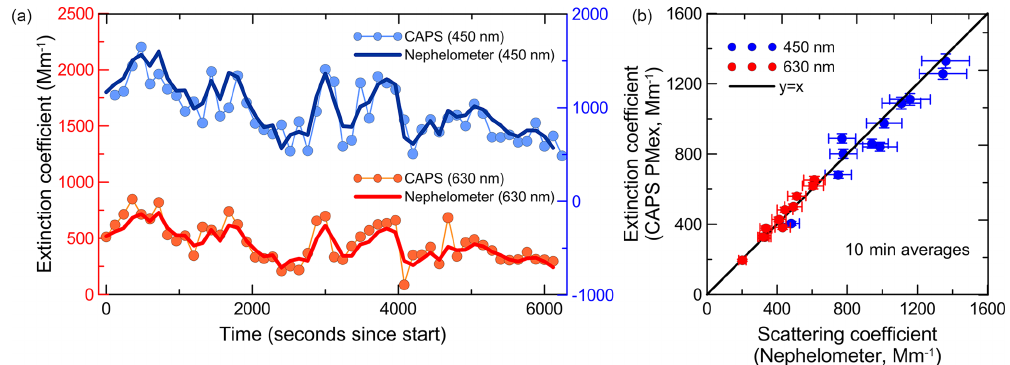
Figure 3. Ammonium sulfate experiment. (a) Temporal evolution of the extinction and scattering coefficients measured by the CAPS PMex and the nephelometer at 450nm (blue scale) and 630nm (red scale). Each point in the plot corresponds to 2min average data. (b) CAPS PMex versus nephelometer data (10min averages). The y = x line and the results of the linear fit between CAPS and nephelometer data are also shown in the plot.